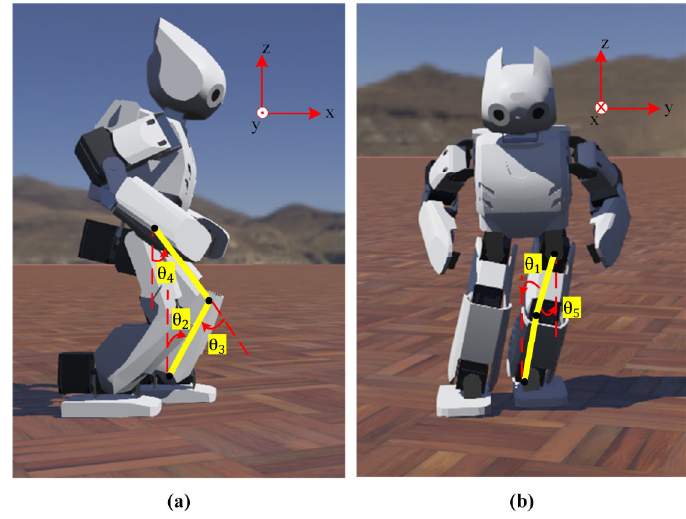
Figure 5. Leg joints of Robotis-OP2: ( a ) link lengths, ( b ) placement of the axes. In Figure 6, the representation of the leg joint angles is given.